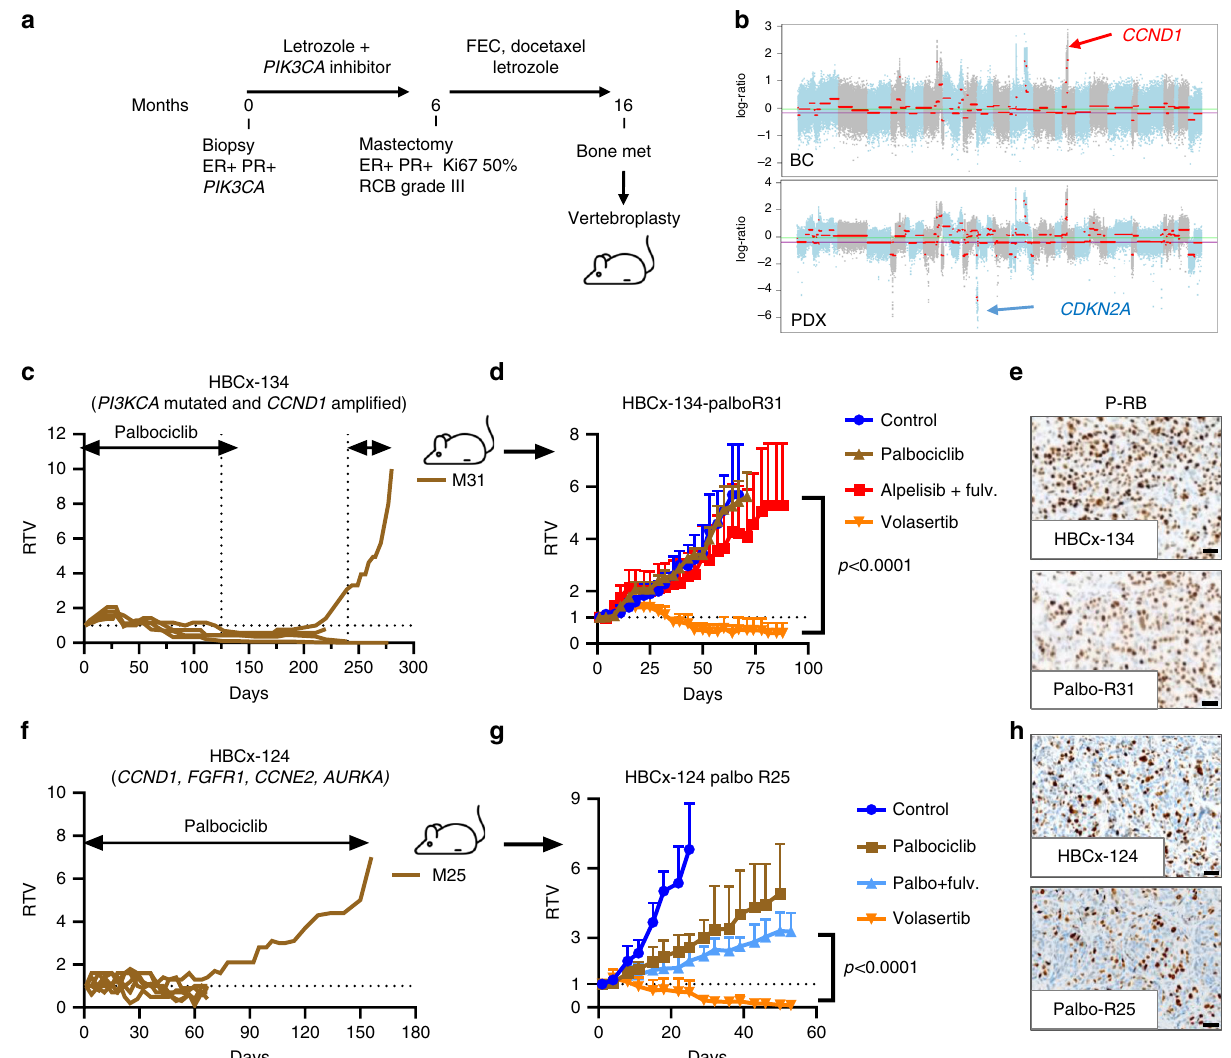
Fig. 3 Reponse to volasertib in CCND1 -driven PDX models with acquired resistance to palbociclib. a Clinical history of the patient corresponding to HBCx-134 PDX: the patient ’ s tumour carries a PIK3CA mutation and the patient was treated by a PI3K α inhibitor + an aromatase inhibitor in the neo- adjuvant setting. At mastectomy the pathological analysis classi fi ed the tumour as RCB-III (resistance to neo-adjuvant treatment). The patient was